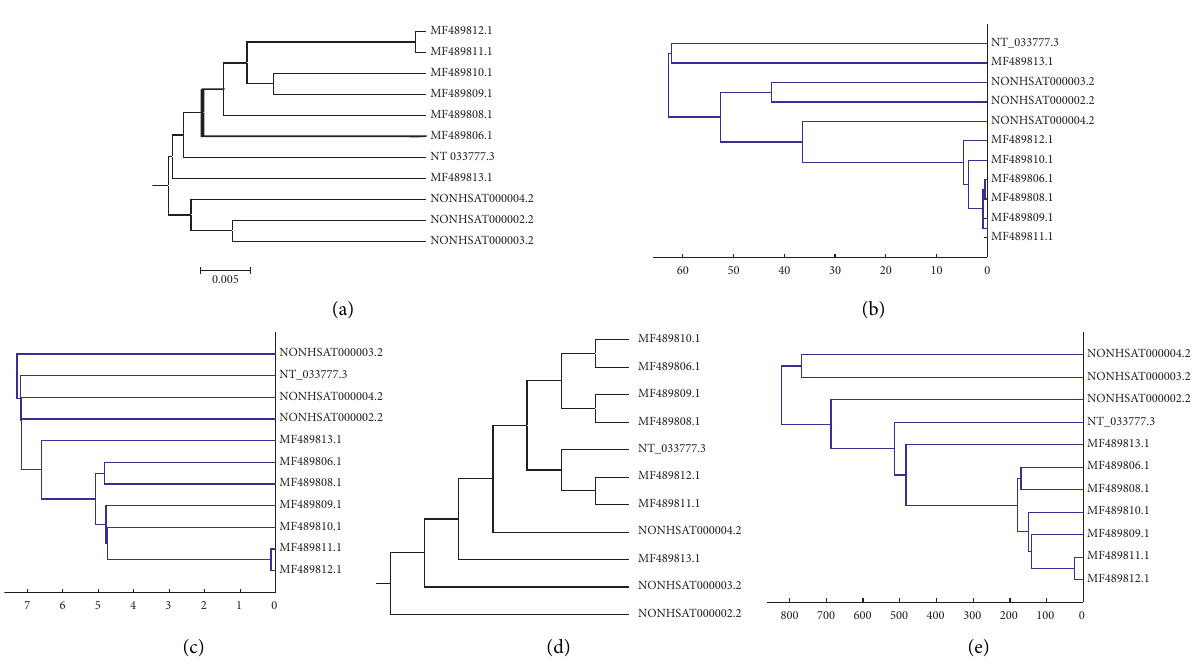
Figure 7: The cluster analysis graphs of 11 noncoding RNA sequences generated by (a) our method, (b) Li’s method, (c) RNApdist, (d) ASPRAlign, and (e) MEGA